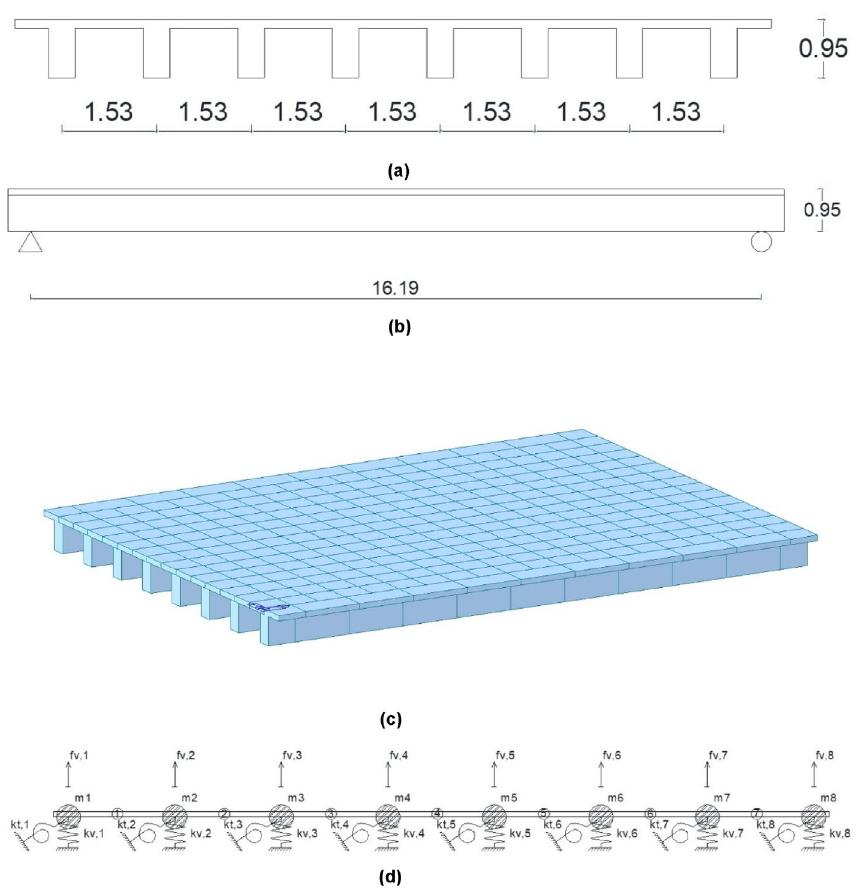
Figure 9. Structural model of the girder deck analyzed: ( a ) cross-section; ( b ) longitudinal profile; ( c ) traditional grillage model; ( d ) structural model